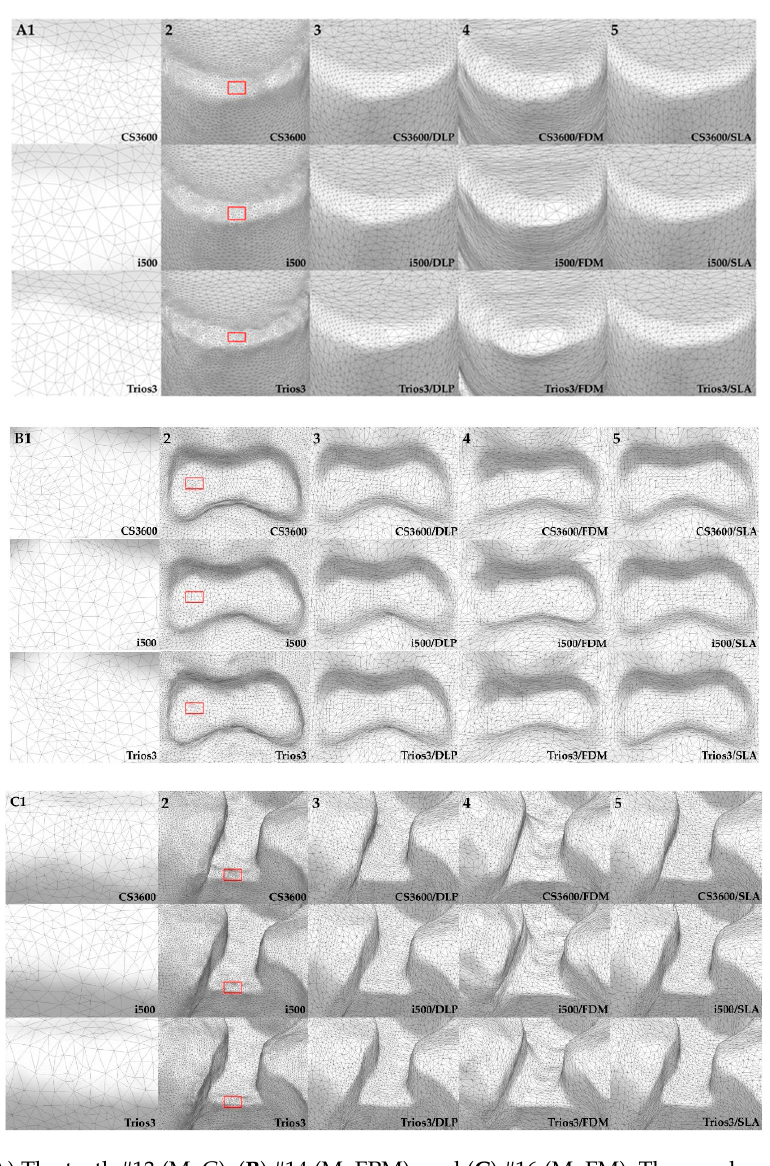
Figure 5. ( A ) The teeth #13 (MxC), ( B ) #14 (MxFPM), and ( C ) #16 (MxFM). The numbers of per unit area compared in terms of the density and geometry of the triangle polygons for qualitative evaluation of each intraoral scanners (IOSs) and 3DP STL data.